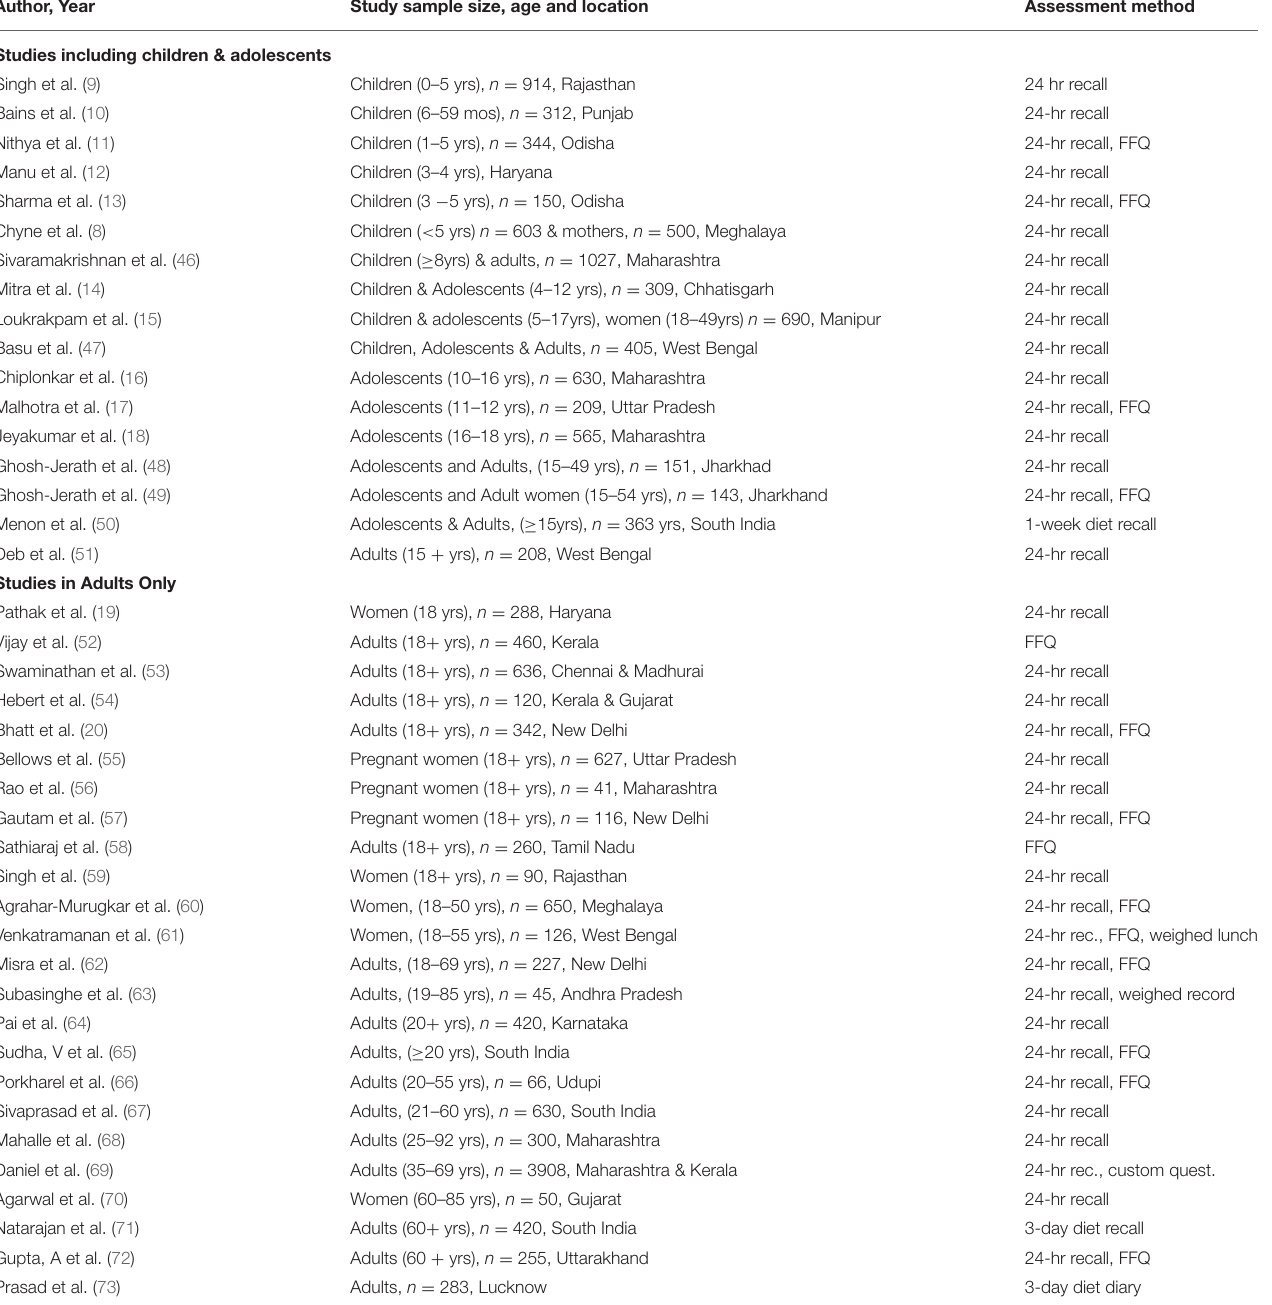
TABLE 2 | Studies in India Assessing Nutrient Intake and Assessment